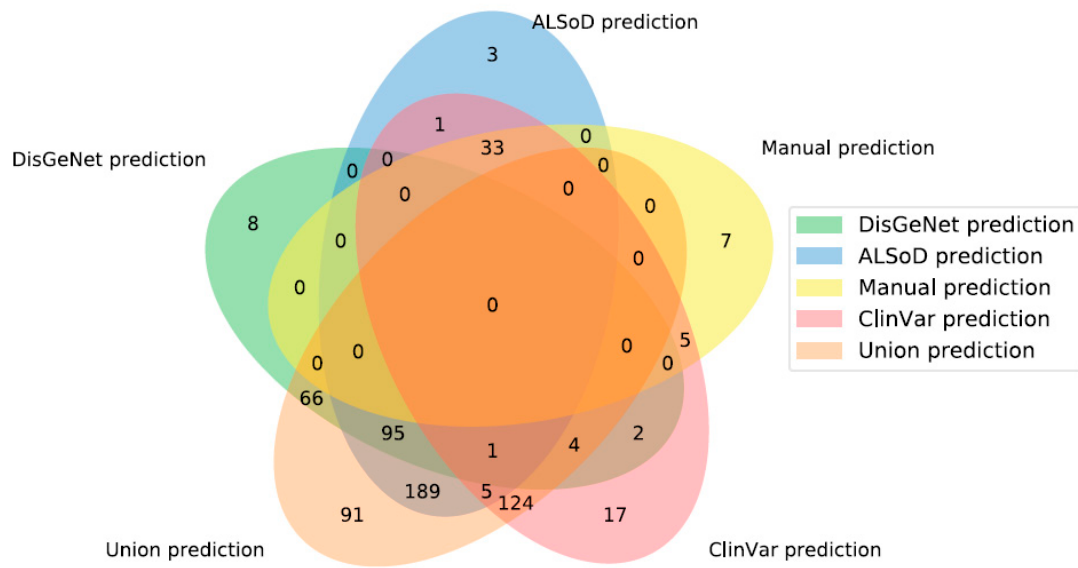
Figure 2. Overlap of predicted ALS-linked genes from the five gene lists. “Union prediction” is the new predictions made, based on the union of all other lists of known linked genes, not the union of all predictions. Note that areas are not to scale.